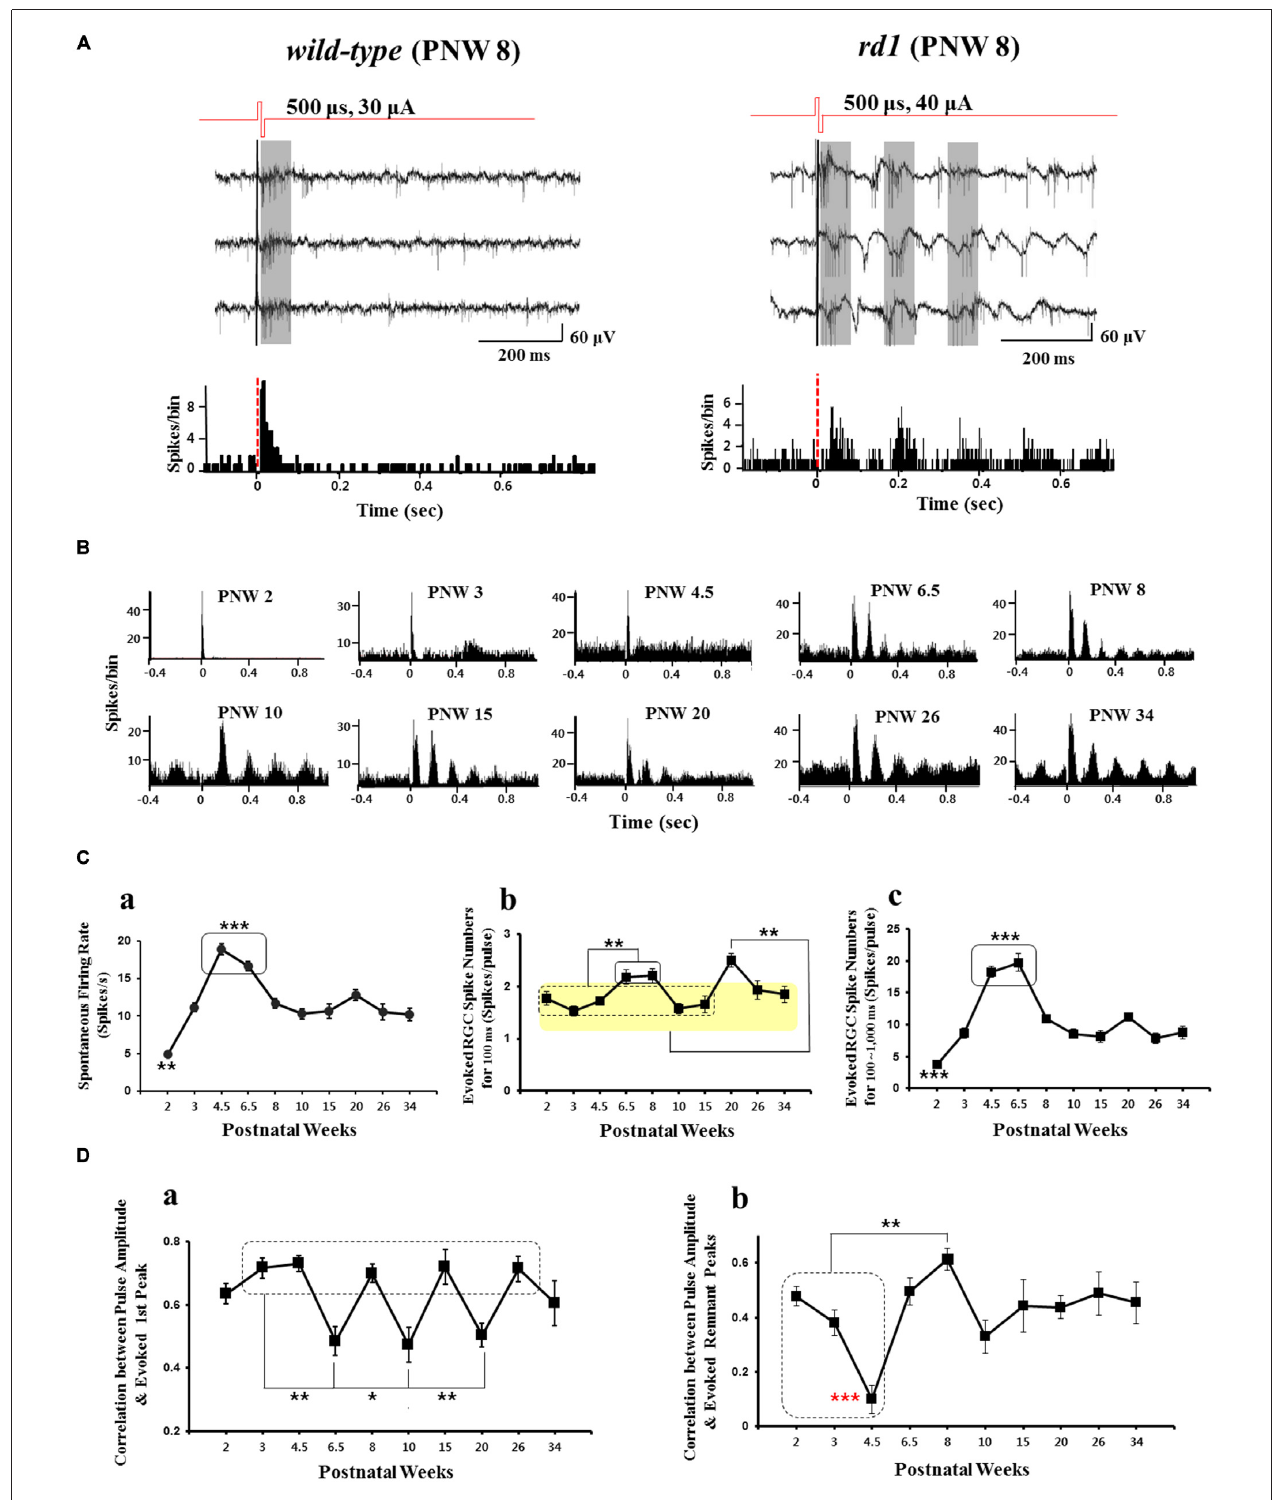
FIGURE 2 | Electrically-evoked RGC spikes response across different postnatal age. (A) Typical recording of electrically-evoked RGC spikes in wild-type (left panel), rd1 (right panel) mice retinas. Biphasic current pulses, 30 and 40 µ A amplitude and 500 µ s width were applied for wild-type and rd1 , respectively. Wild-type mice (at postnatal 8 week) typical waveforms show only few evoked spikes with the PSTH derived from 50 stimulus trains showing typical single peak with the latency of less than 100 ms. In rd1 mice (postnatal 8 week), there is a ∼ 10 Hz background oscillatory rhythm and rhythmic bursting type firing of RGC spikes (marked by gray zone) and multiple ( ∼ 4) peaks with ∼ 10 Hz rhythm within 400 ms on the PSTH. Here, not the RGC response to voltage stimuli but that to current stimuli is shown. In rd1 retina, multiple peaks with 10 Hz rhythm in PSTH are observed with current stimulus as in Ye et al. (2008), Ryu et al.